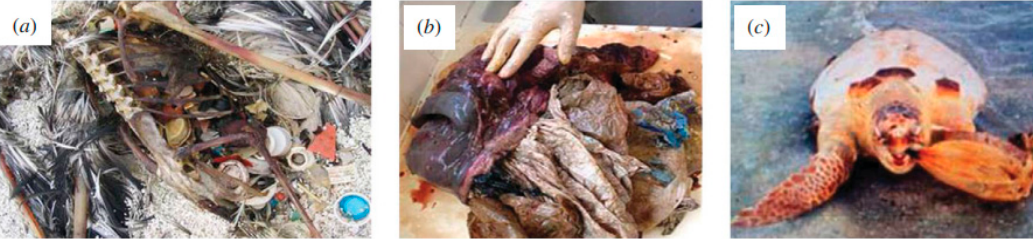
Figure 4. Examples of ingestion: ( a ) Laysan Albatross; ( b ) plastic from the stomach of a young Minke whale that had been washed ashore dead in France and ( c ) stranded sea turtle disgorging an inflated plastic bag. (taken from reference [23] with permission of the Royal Society).